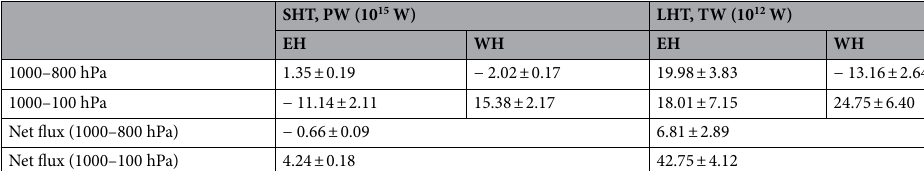
Table 1. Mean heat fluxes of sensible heat transport (SHT) and latent heat transport (LHT) for the Eastern Hemisphere (EH) and Western Hemisphere